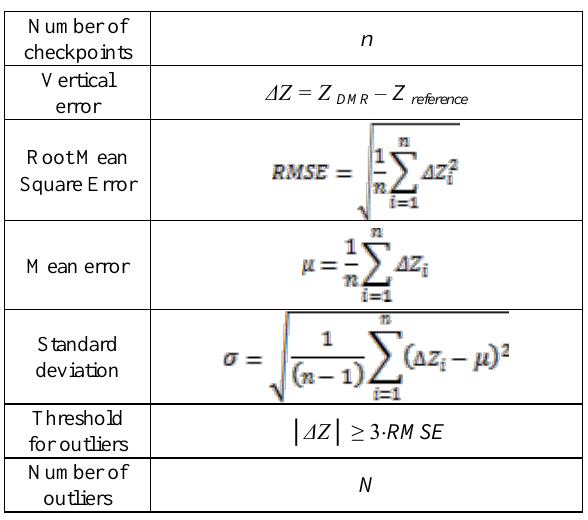
Table 1. Accuracy measures for Z coordinate (Höhle and Potuckova, 2011; page 37)